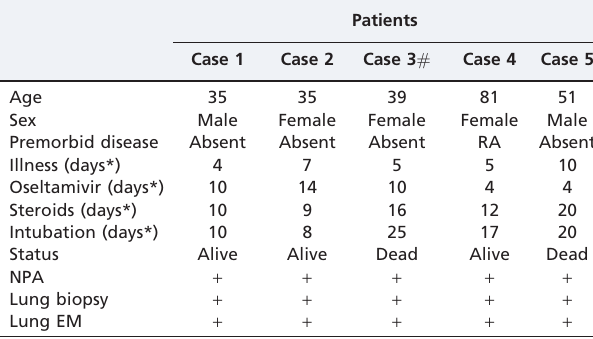
Table 1 - Clinical features of the